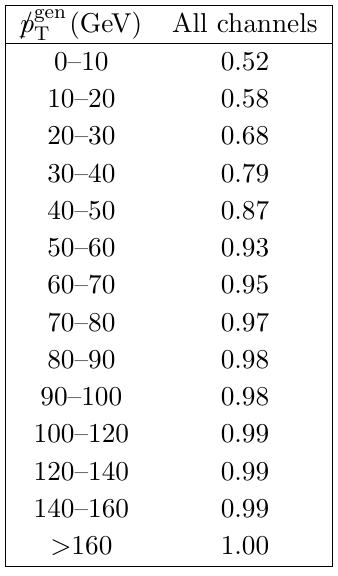
Table 9 . E(cid:14)ciencies of the p miss